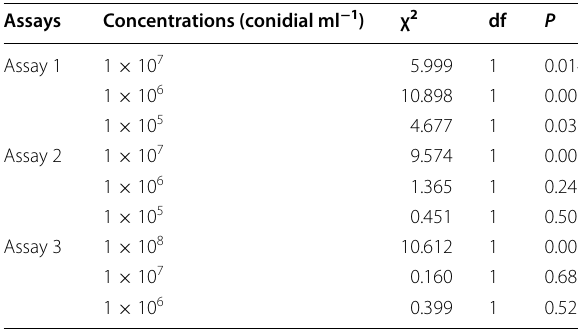
Table 2 Results of the log-rank test on the different fun- gal strains Bb -AaIT and WT against Aedes albopictus (larval or female adult mosquitoes) at each given concentration in assays 1–3